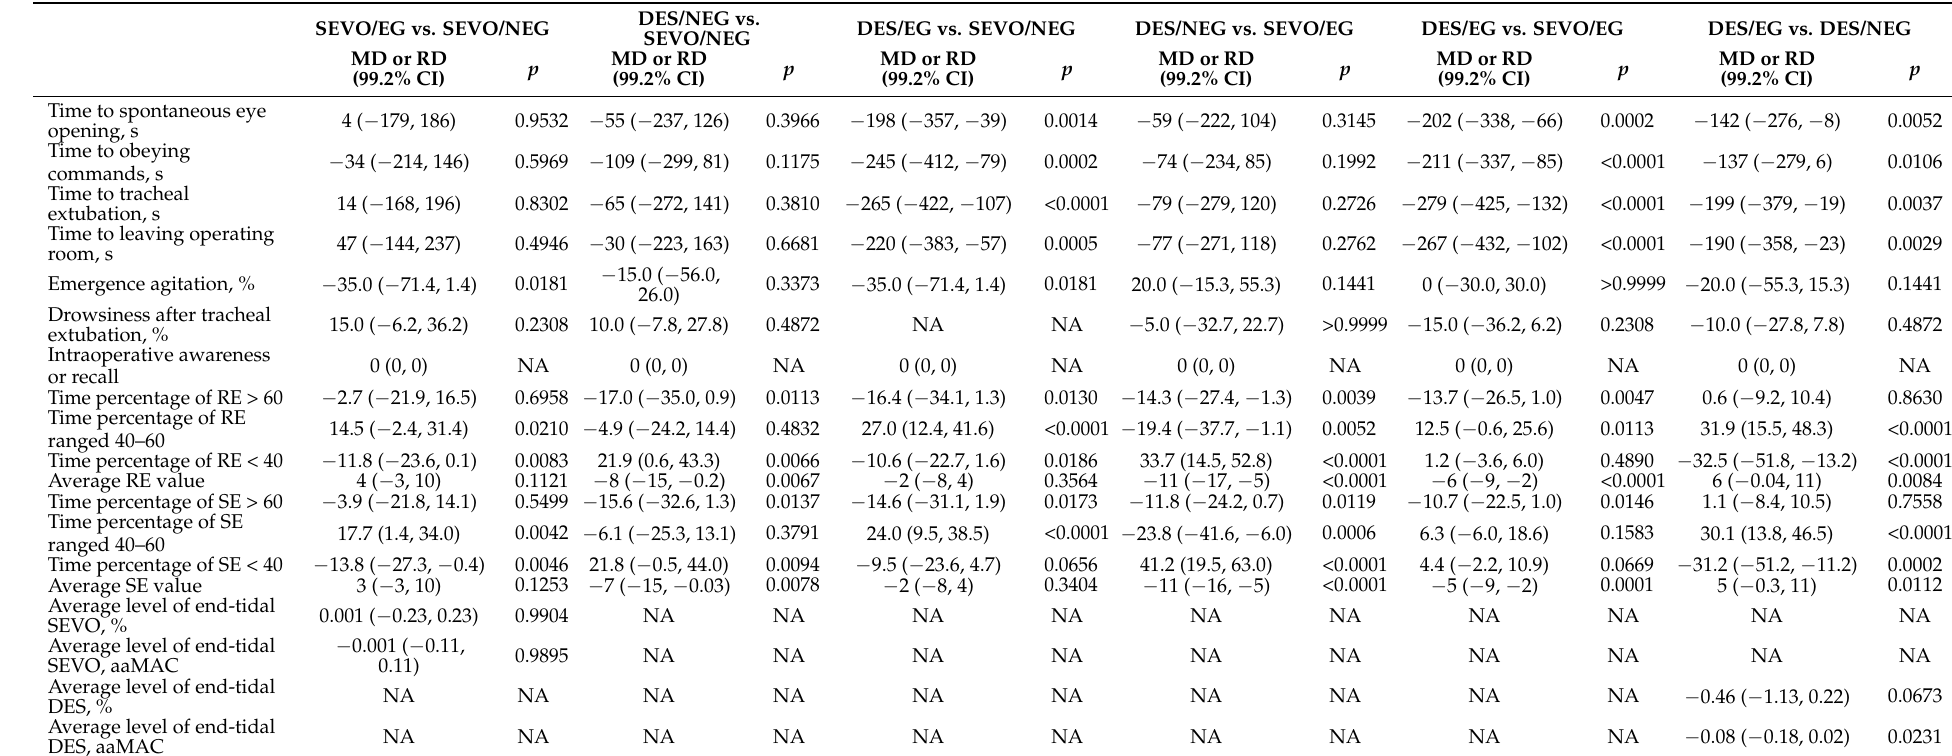
Table 5. Intergroup comparisons for study